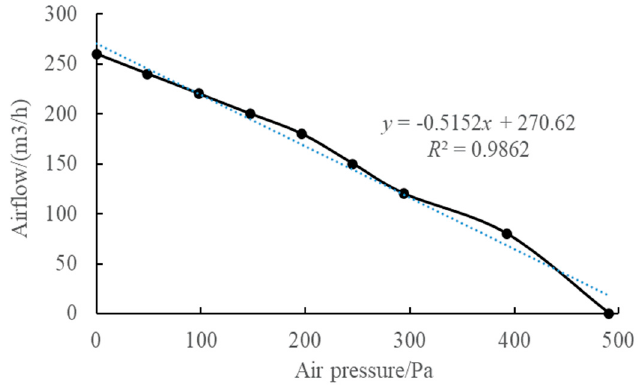
Figure 7. Performance curve of blower.